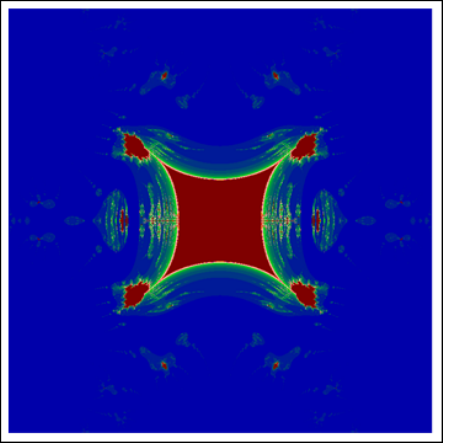
Figure 60. Multi-corn via F-iteration with image visual time = 193.3 s.